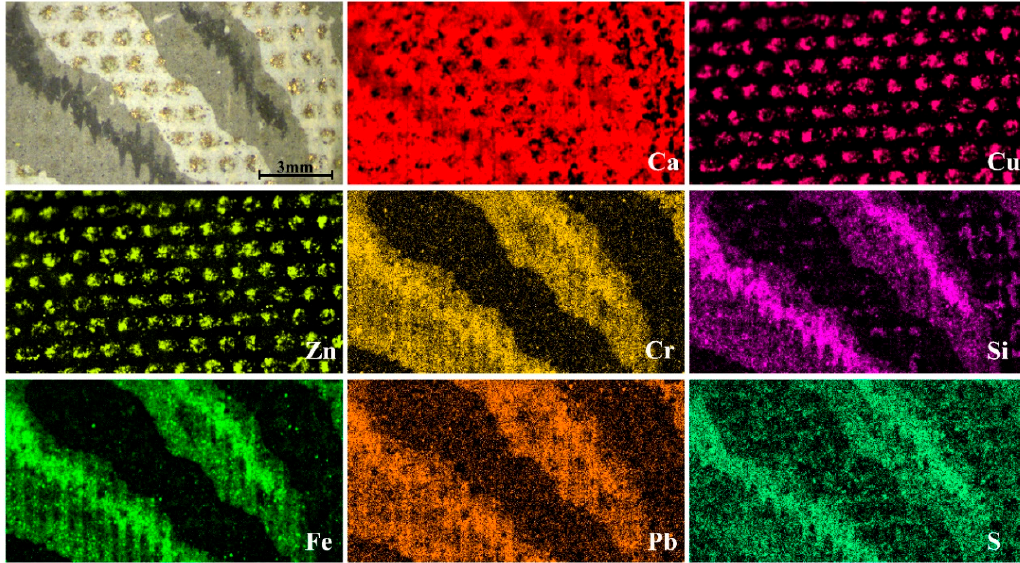
Figure 5. Micro-EDXRF maps from a decorative wallpaper (sample wp4). After the systematic application of brass all over the paper, other pigmented layers were applied.